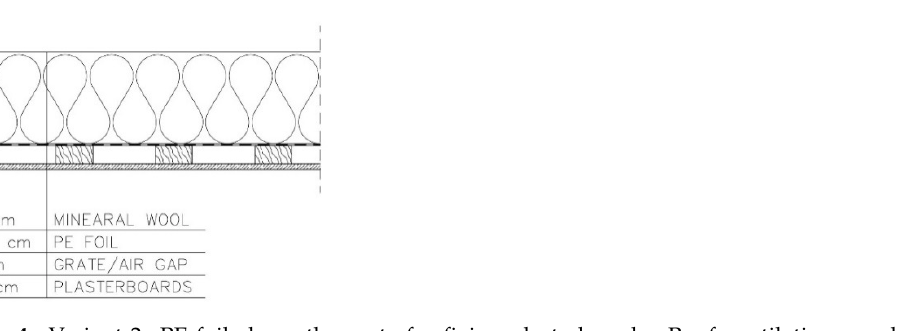
Figure 3. Variant 1: PE foil under the grate for fixing plasterboards. Roof ventilation equal to 20 changes per hour. − Variant 2—PE foil above the grate for fixing plasterboards. Roof ventilation equal to 20 changes per hour (Figure 4).